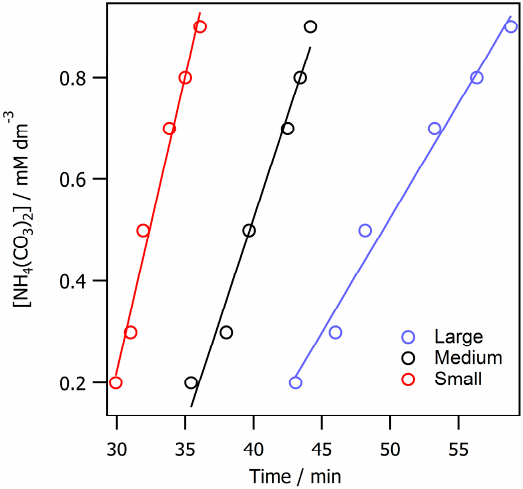
Figure 1. Ammonium carbonate dissolution rates. Temporal evolution of ammonium carbonate concentration for each of the three desiccators; rates of dissolution are 0.045, 0.080, and 0.115 mM · min − 1 for the large, medium, and small desiccators respectively.